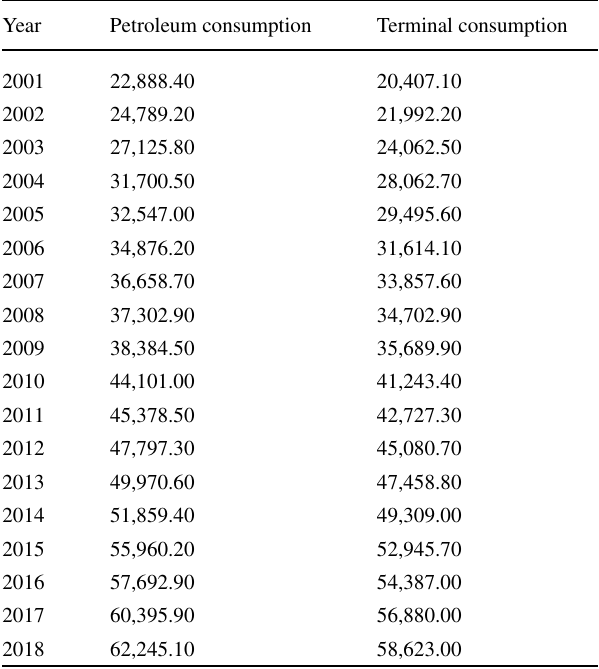
Table 3 China’s petroleum consumption and terminal consumption from 2001 to 2018 [unit:10 4